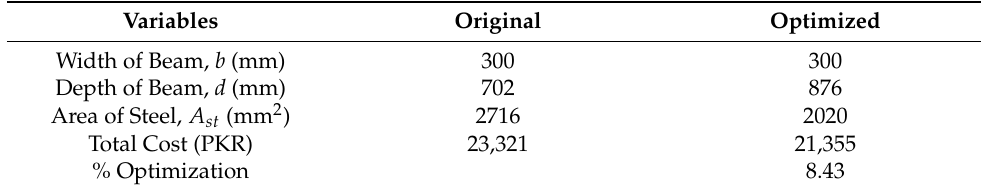
Table 3. The optimization results for Example 2.